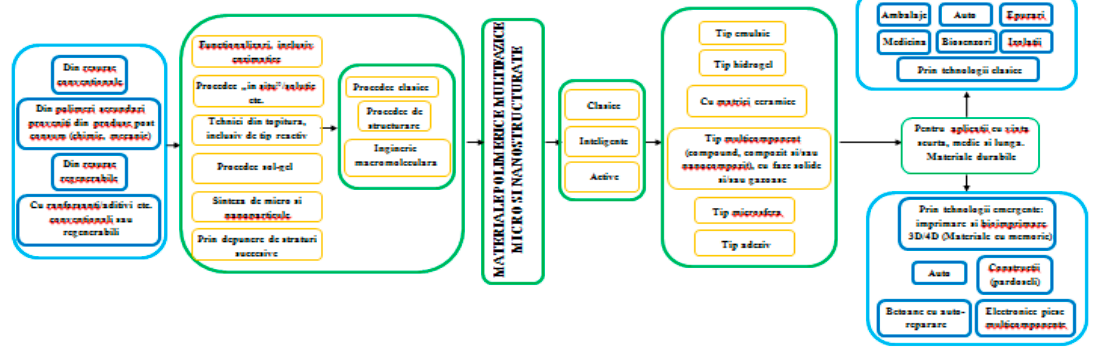
Figure 1. The ICECHIM strategy in the advanced polymeric materials domain